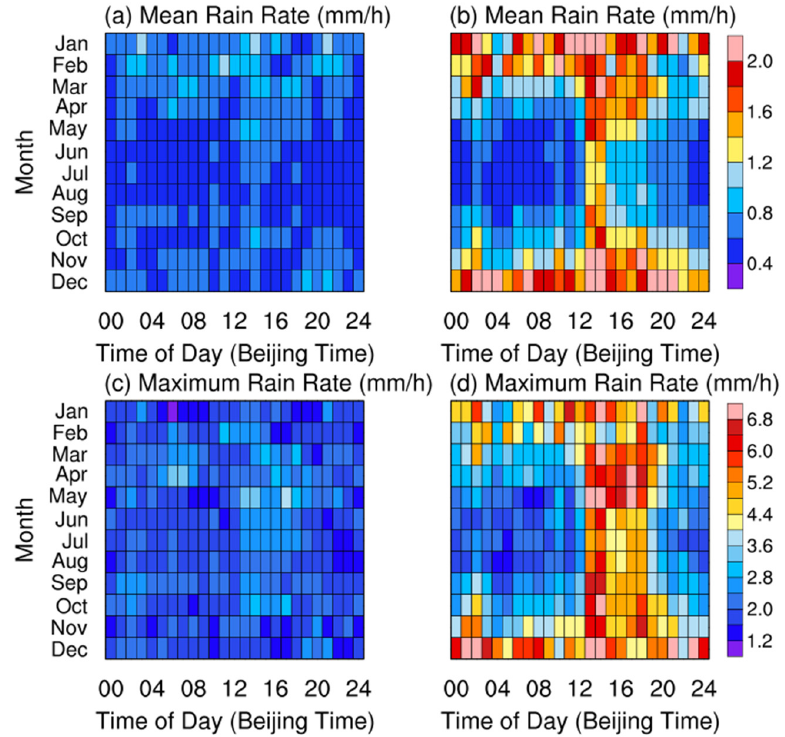
Figure 8. Intra-annual variations in the parameters of oceanic and continental rain clusters: ( a,b ) mean rain rate and ( c,d ) maximum rain rate. The left-hand columns show the parameters of oceanic rain clusters and the right-hand columns show the parameters of continental rain clusters (Beijing Time, UTC+8).